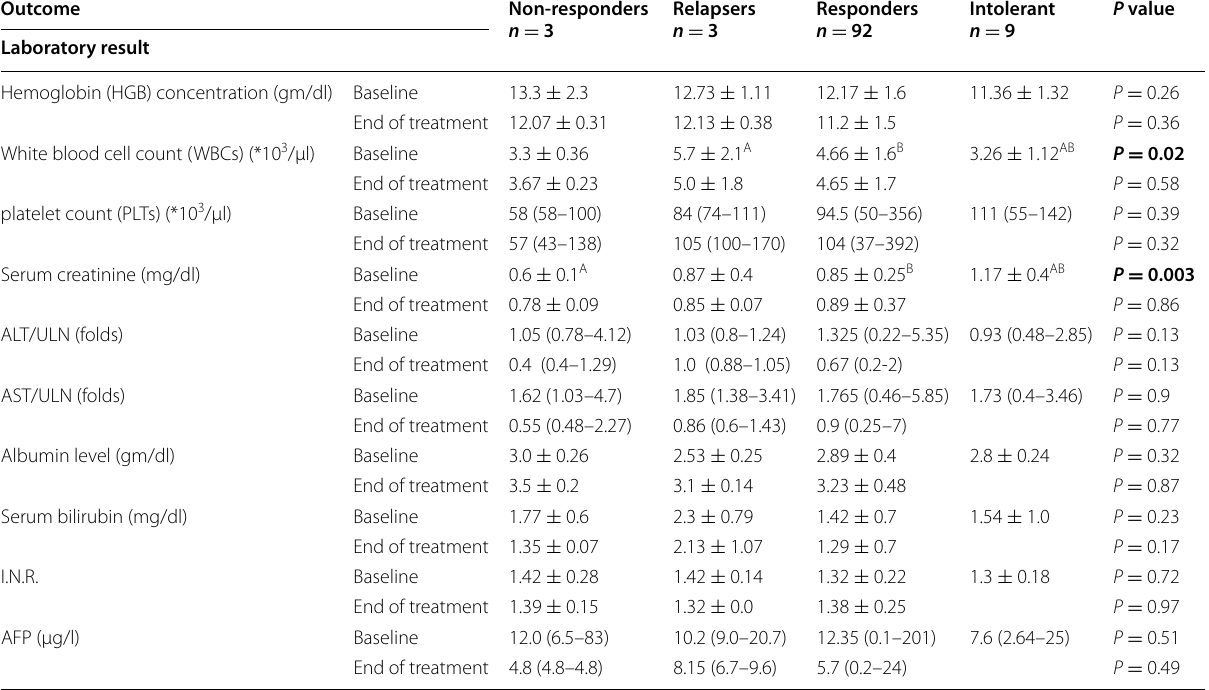
All parameters described as mean SD except platelet count, ALT/ULN, AST/ULN, serum bilirubin, and AFP as median (min–max) ± Table 4 Laboratory results at baseline and at the end of treatment in relation to treatment outcome